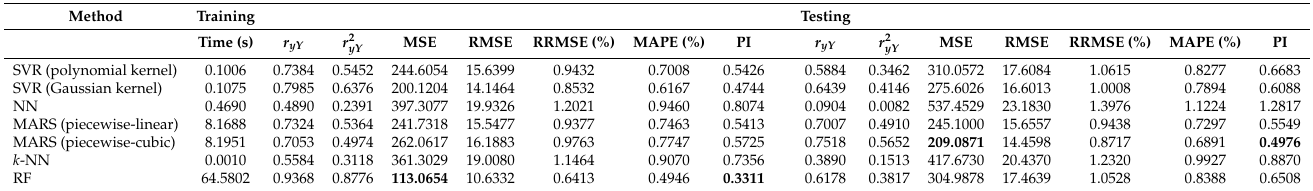
Table 4. Performance of the machine learning methods in temperature prediction based on static data.